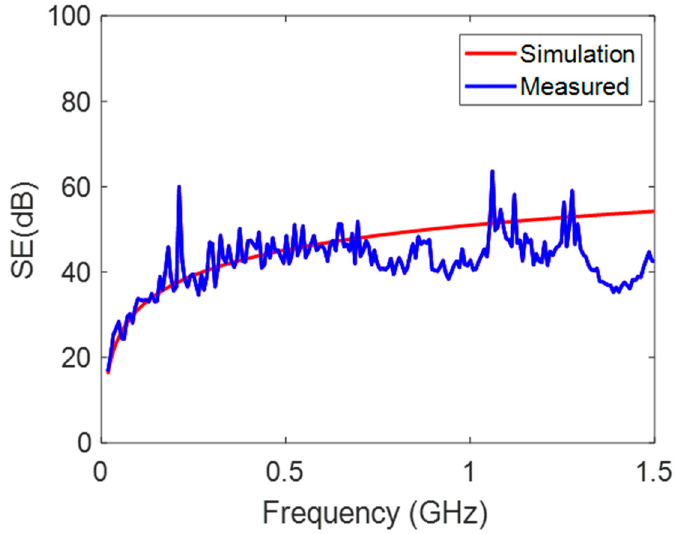
Figure 12. EMI SE of the PPA-based material with an aluminum bronze coating.